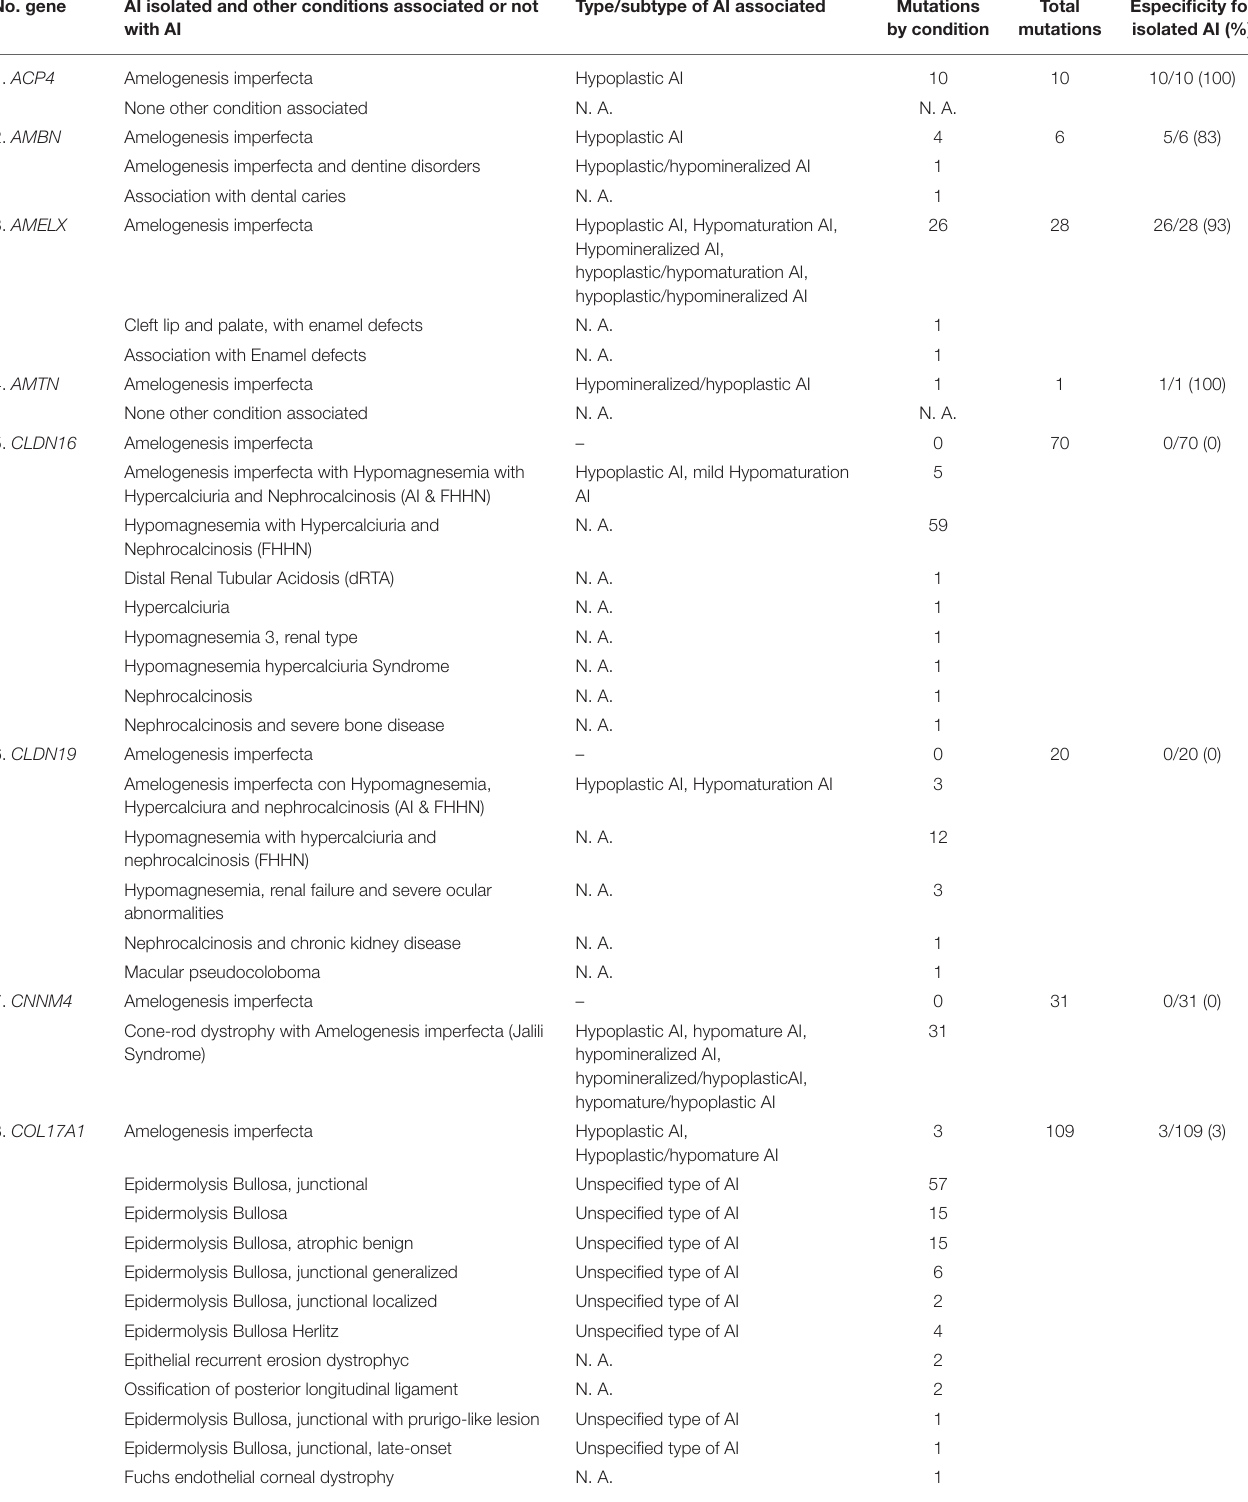
TABLE 1 | Specificity of the causative genes of Amelogenesis imperfecta to determine AI in isolation form. No.